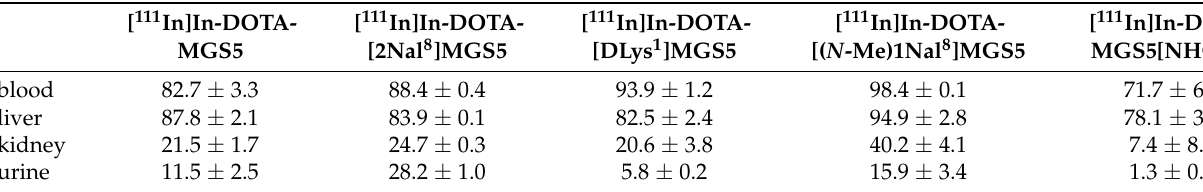
Table 3. HPLC analysis of samples obtained from metabolic studies in BALB/c mice analyzing the percentage of intact radiopeptide 10 min p.i. Data of previously studied [ 111 In]In-DOTA-MGS5 are added for comparison [19].